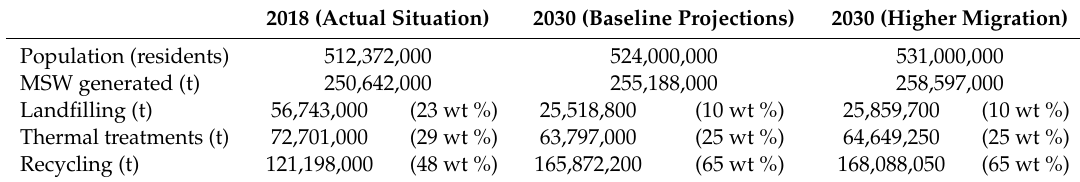
Table 1. MSW management in EU-28: actual situation and future perspectives related to the application by 2030 of a “recycling and thermal treatment only”